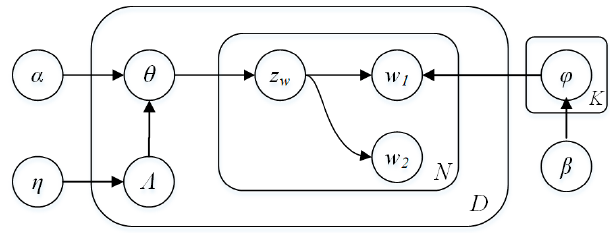
Figure 4. Generation process of LB-LDA.